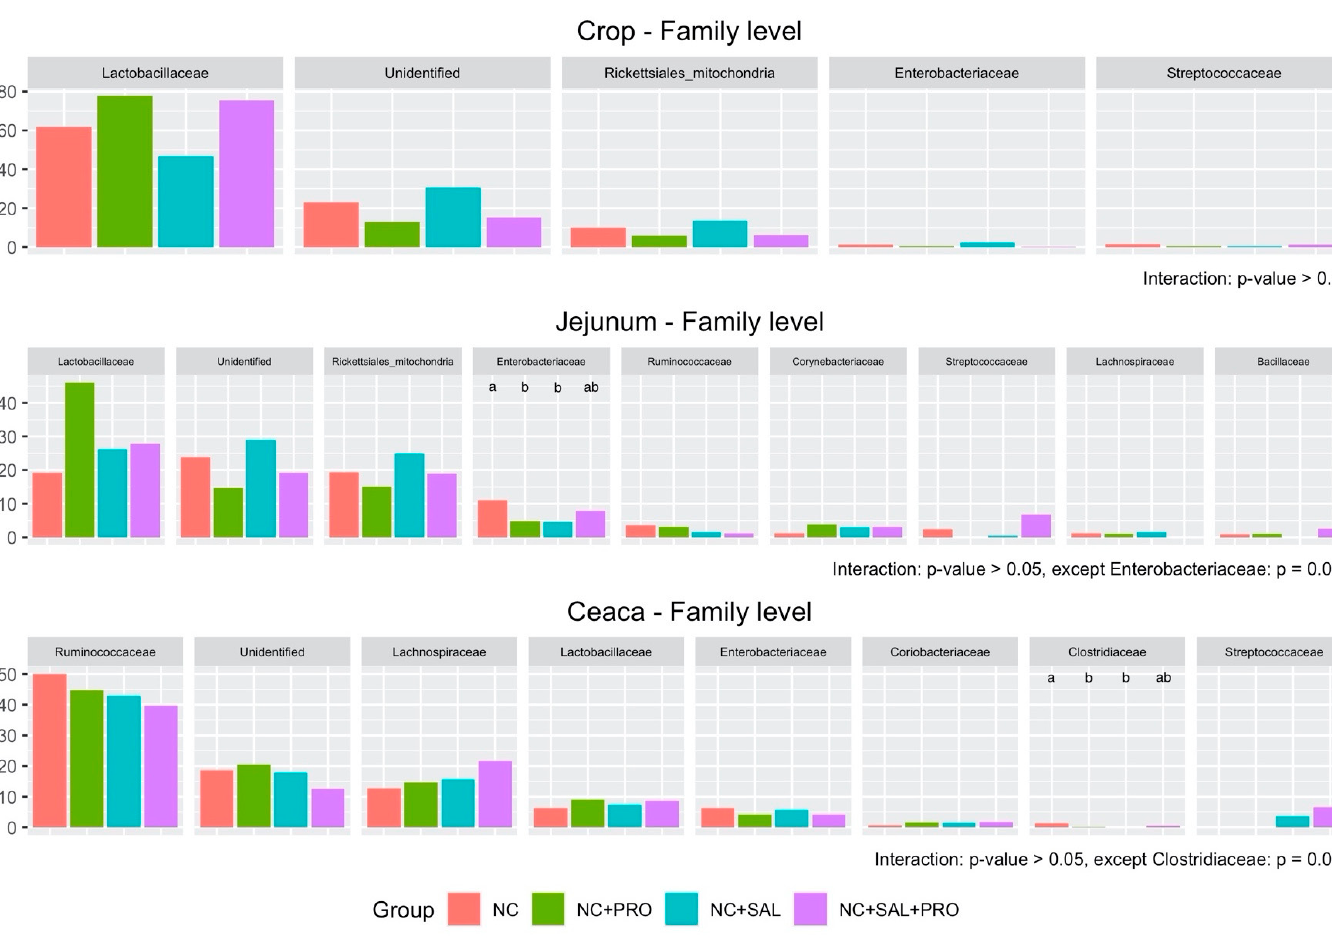
Figure 4. Relative abundance of dominant microbiota at the family level in the crop, jejunal, and cecal digesta samples: NC—control diet with no additives; NC + PRO— B. licheniformis preparation (1.6 × 10 9 CFU / kg diet); NC + SAL—salinomycin addition (60 ppm); NC + SAL + PRO—a mixture of salinomycin (60 ppm) and B. licheniformis (1.6 × 10 9 CFU / kg diet); means represent 10 pens of one chick each pooled by two ( n = 5).